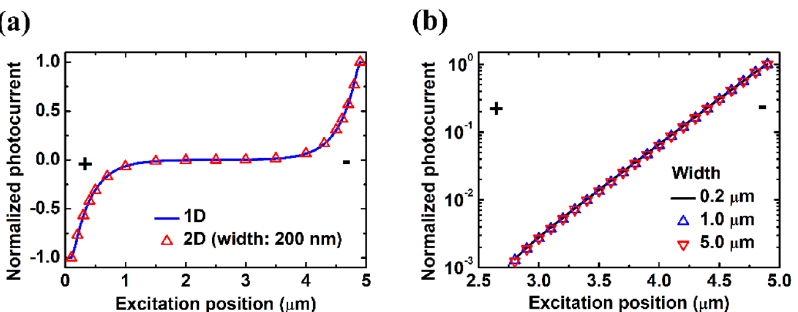
Figure 5. In Schottky-contact based devices. ( a ) Scanning photocurrent profiles of the 0.2 μm wide case compared with the 1D transport structure. Our previous simulator was used in 1D simulation. ( b ) Scanning photocurrent profiles on the cathode side with different widths. Fitted decay length extracted from ( b ) is around 0.323 μm.